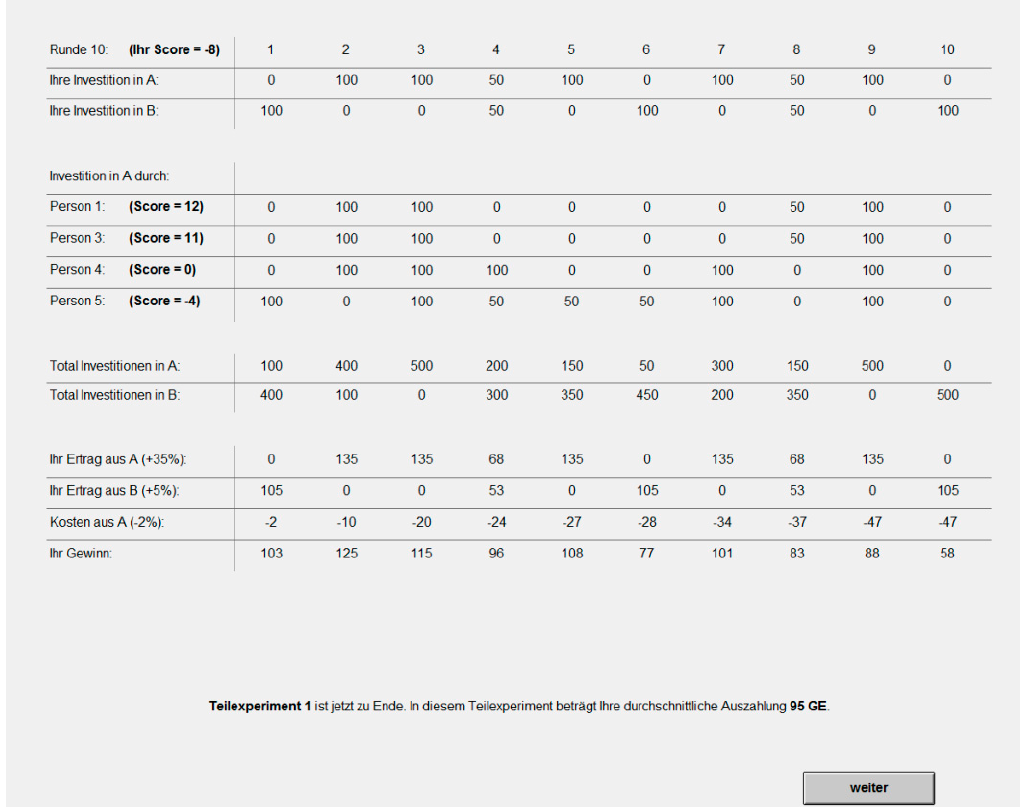
Figure A2. Rating screen of Person 2 in feedback conditions.